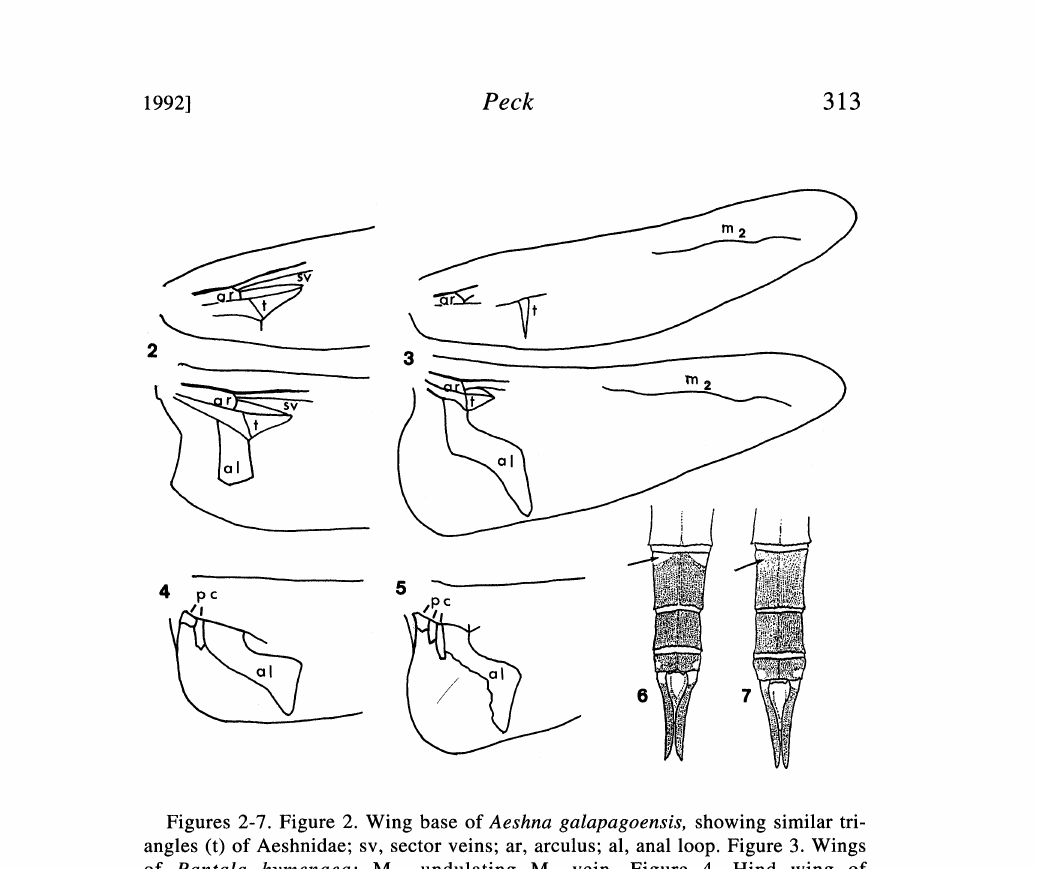
Figures 2-7. Figure 2. Wing base of Aeshna galapagoensis, showing similar tri- angles (t) of Aeshnidae; sv, sector veins; ar, arculus; al, anal loop. Figure 3. Wings M of Pantala hymenaea; M 2 vein. Figure 4. Hind wing of 2, undulating Brachymesia herbida, showing two paranal cells before start of anal loop. Figure 5. Hind wing of Tramea cophysa showing three paranal cells (pc) before start of anal loop (al). Figure 6. Male abdominal tip of T. calverti. Figure 7. Male abdominal tip of T. cophysa. Figs 6 and 7 from De Marmels and Racenis 1982. 6a. Underside of abdomen black; abdominal segment 8 all black (Fig. 7); hindwing clear with sharply edged dark basal band; male at maturity with frons all violet, male face black Tramea cophysa 6b. Underside of abdomen brown to red; abdominal segment 8 with a semicircular pale basal-lateral spot (Fig. 6); hindwing tinged brown with an amber-edged basal band; male with only broad band on top of frons violet; female band on frons top narrower, lower frons and face otherwise pale; male at matu- rity with lower frons and face red Tramea